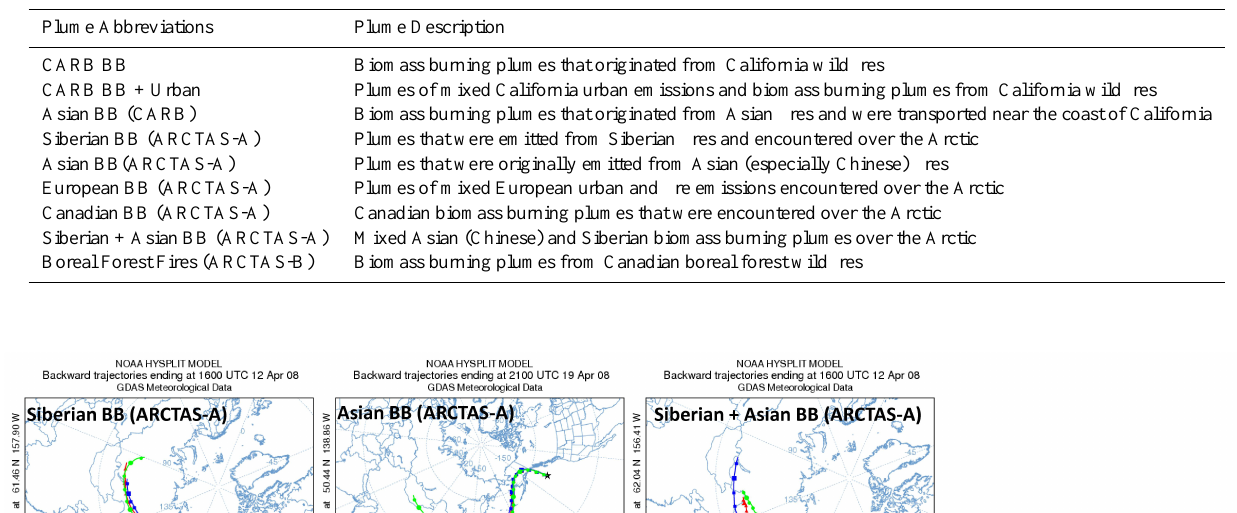
Table 2. Abbreviations and Description of Plumes Selected during the ARCTAS-2008 Study.